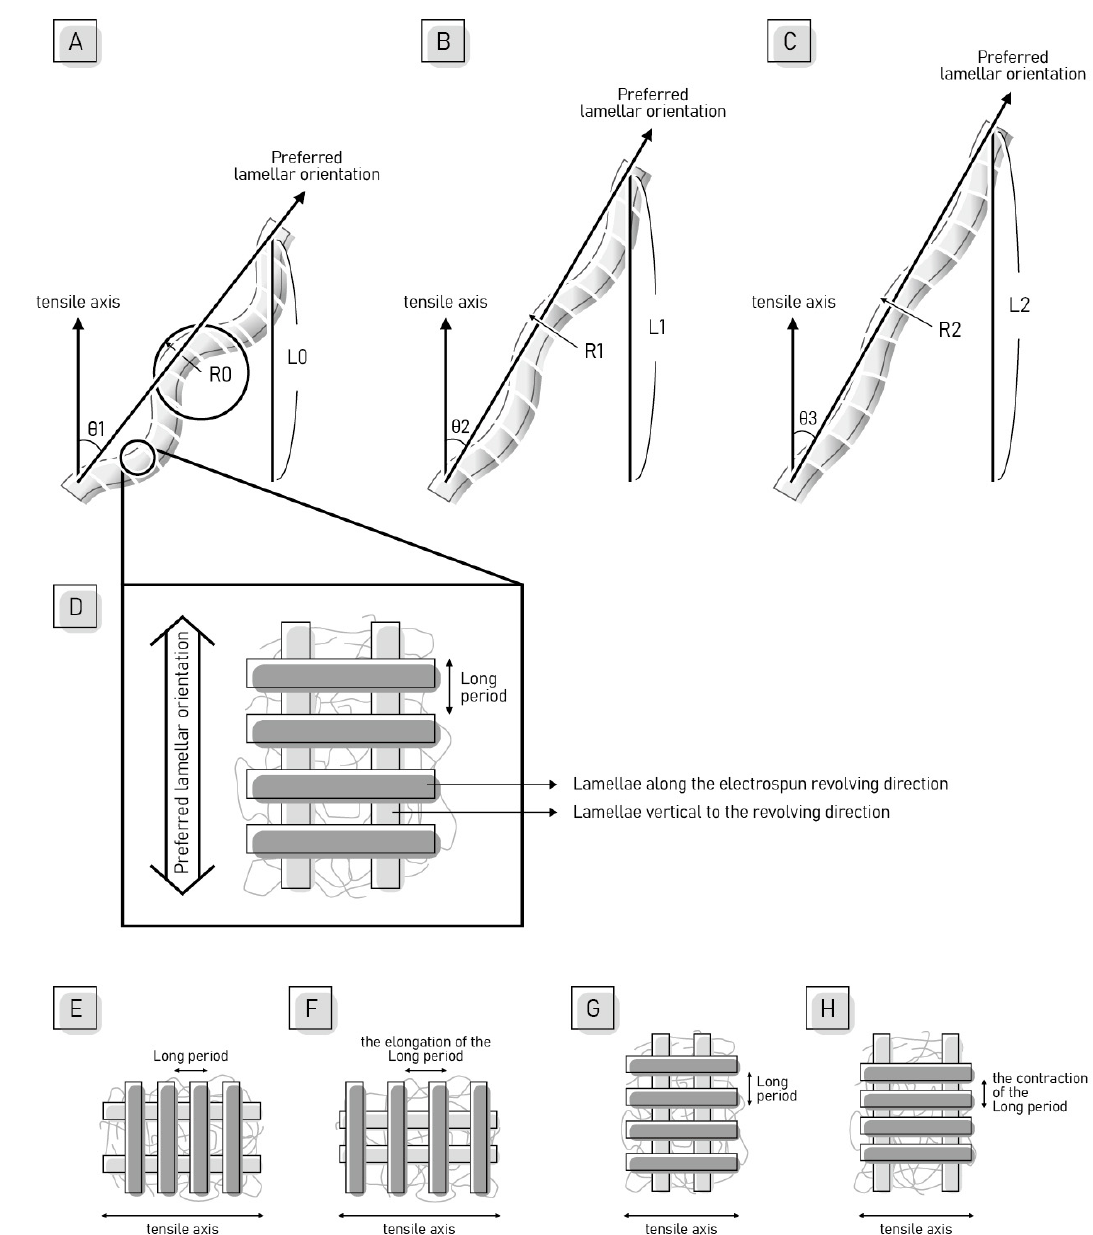
Figure 11. Schematic diagrams of the deformation mechanism of nanofibers under tension at a two-length scale. ( a – c ) Schematic diagram of the deformation mechanism of nanofibers on the nanometer scale. ( d – h ) Schematic diagram of the deformation mechanism of nanofibers on the sub-nanometer scale.